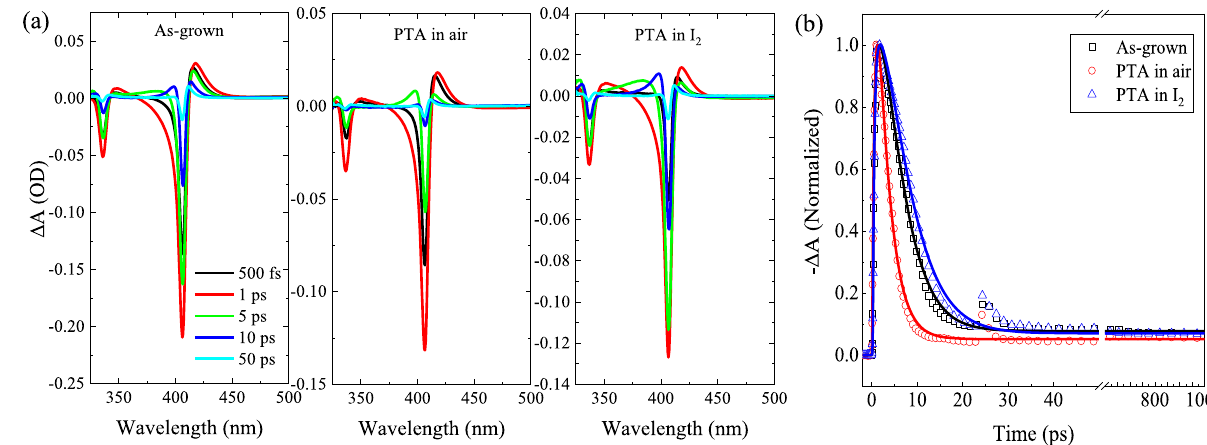
Fig. 9 | Dependence of ultrafast carrier dynamics on defects. a TA spectra of CuI thin fi lms with different treatments ( F p =2.54mJ/cm 2 , λ p =320nm). b Normalized PB dynamics probed at the 406nm, with the lines the corresponding fi